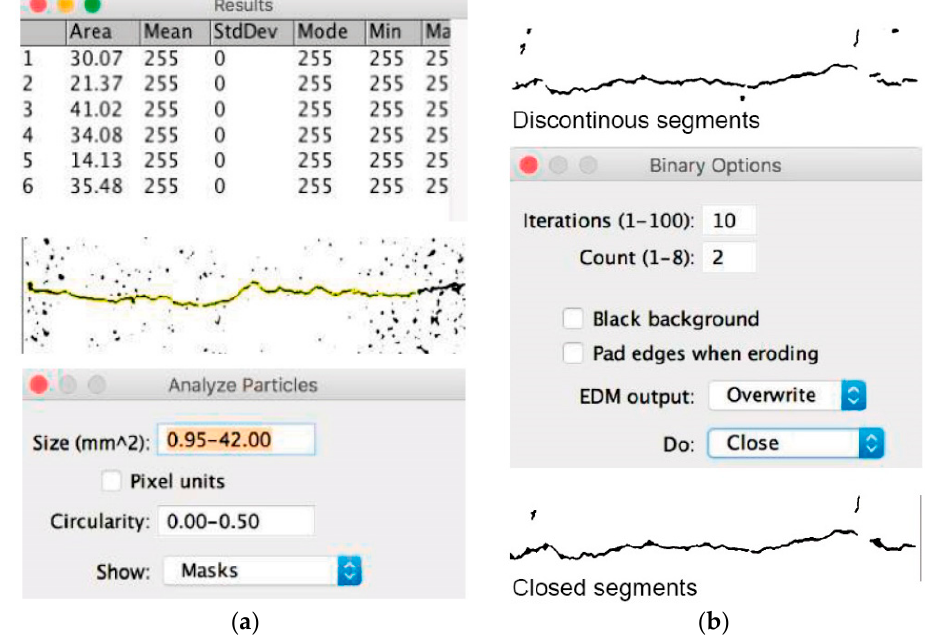
Figure 18. Image post-processing: ( a ) “Analyze Particles” tool: circularity; and ( b ) joining of discontinuous segments by using binary options.